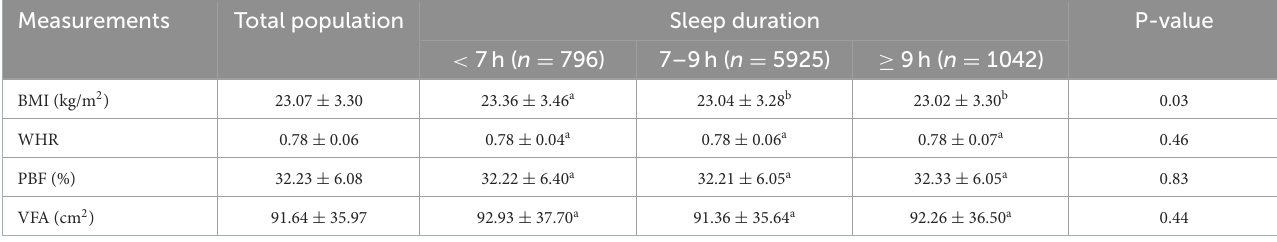
TABLE 2 Obesity measurements of study participants by sleep duration groups ( n = 7763).